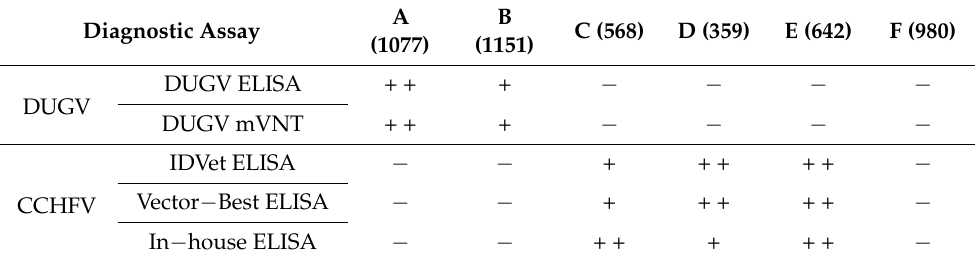
Table 4. Corresponding data to Figure 5.